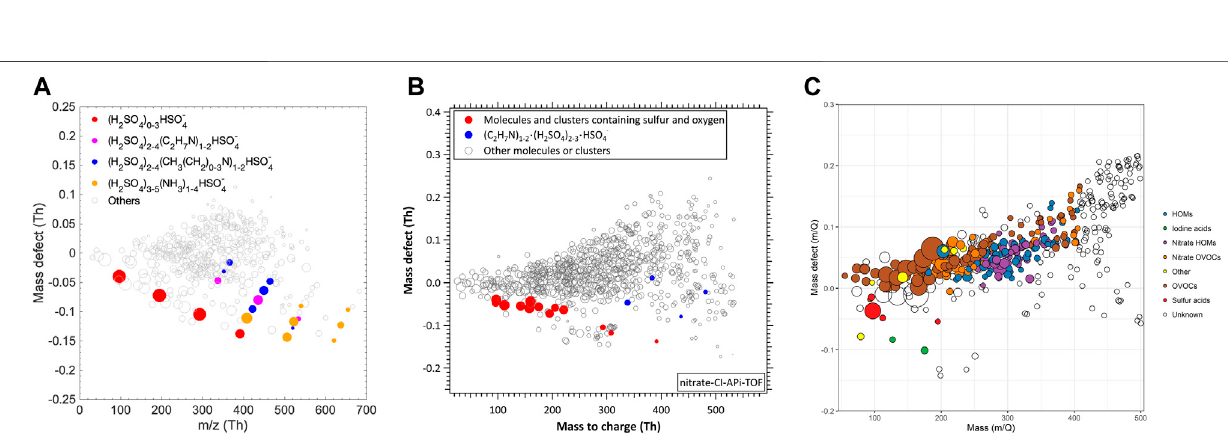
FIGURE3| NitrateCI-APi-TOFmeasurementsduringtheNPFeventsinBeijing,China (A) (Yan,2021);Shanghai,China (B) (Yaoetal.,2018),andBarcelona,Spain (C) (Brean et al., 2020). Note different axes ranges.